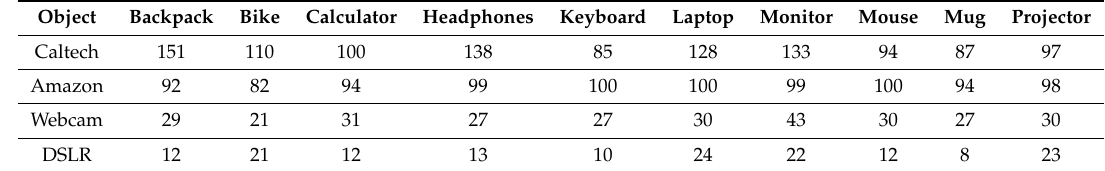
Table 2. Image numbers in